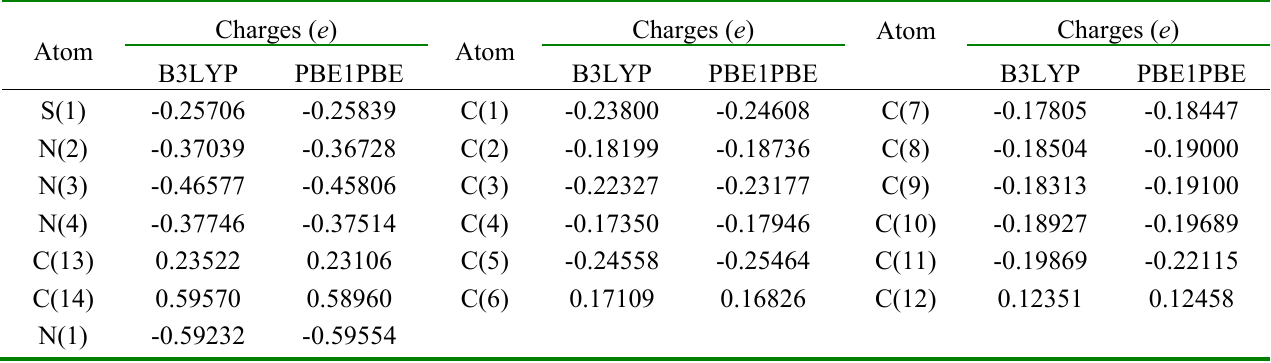
Table 4 . NPA atomic charge distributions obtained at B3LYP/6-311G** and PBE1PBE/6- 311G**